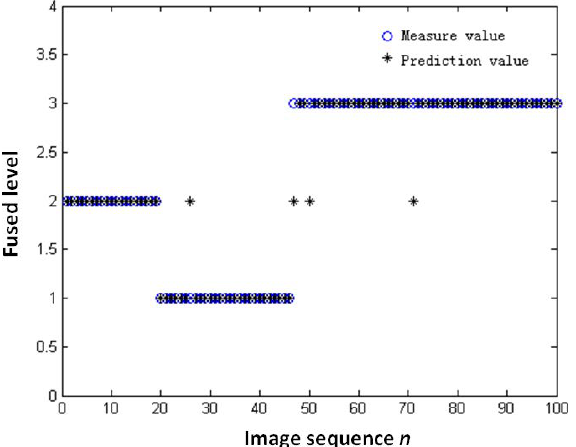
Fig. 13 Verification result for the penetration prediction